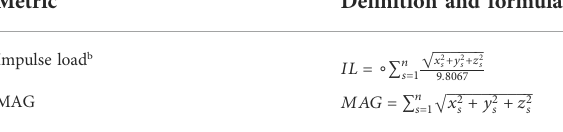
TABLE 1 Formula for each accelerometry based